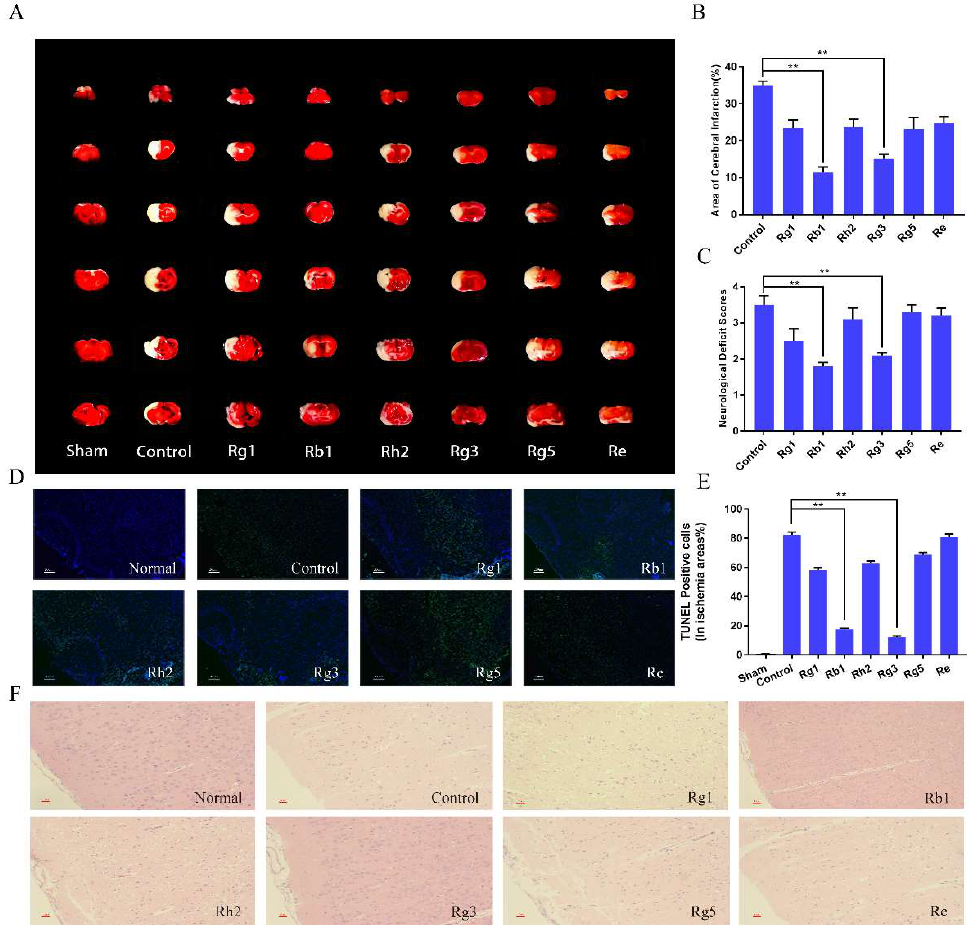
Figure 4. Effects of ginsenoside Rg1, Rb1, Rh2, Rg3, Rg5 and Re on infarct volume ( A , B ) and neurological functional outcome ( C ). Cerebral infarct volume was determined by 2,3,5-triphenyltetrazolium chloride (TTC) staining. In Fig. 4A, the red area represented normal brain tissue and the white area represented infarct area. Data were expressed as mean ± SD, n = 6. ** p < 0.01, compared with positive control. Representative pictures of TdT-mediated dUTP nick-end labeling (TUNEL) ( D ) and H&E staining ( F ) at 24 h after drug treatment and TUNEL positive cells quantitative analysis ( E ). Apoptosis was observed by TUNEL staining and original magnification was 100×. The blue indicated normal neuronal cells, and the green indicated apoptotic cells (200 μm). The damaged nerve cells in H&E staining were shown to be brown with a magnification of 200×. Data were expressed as mean ± SD, n = 6. ** p < 0.01.